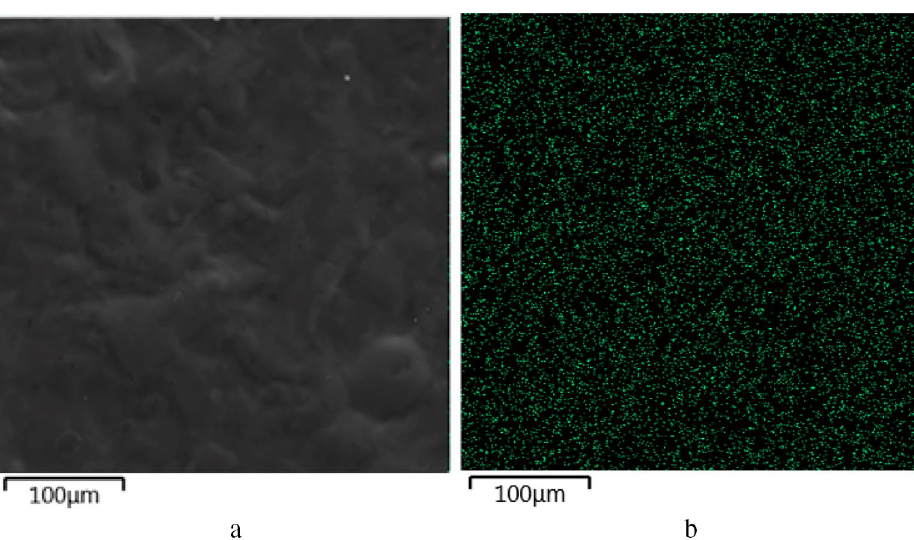
Figure 22. Results of elemental analysis of methylcellulose film modified with 0.8% CuO nanoparticles ( a ) SEM-micrography, ( b ) layer distribution map (Cu).